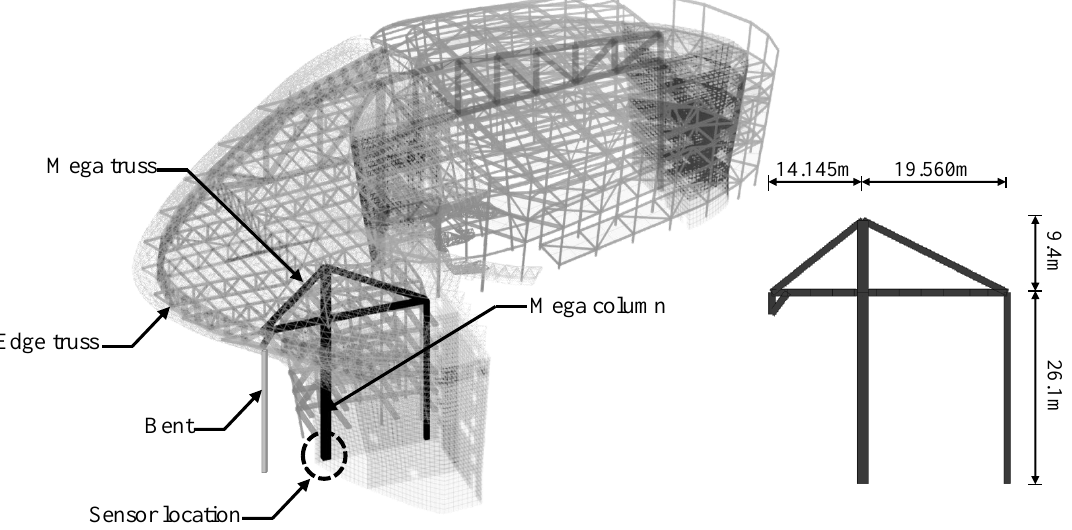
Figure 1. Mega column in a large-scale irregular building structure.